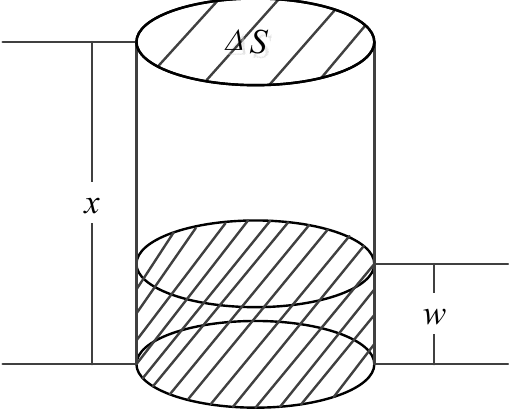
Figure 4. Precipitable water vapor (PWV).